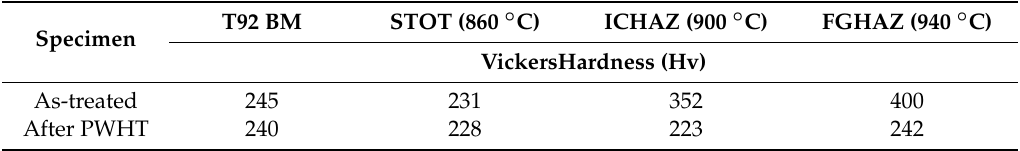
Table 2. The average Vickershardness of the base metal and simulated specimens with or without PWHT at 750 ◦ C/2